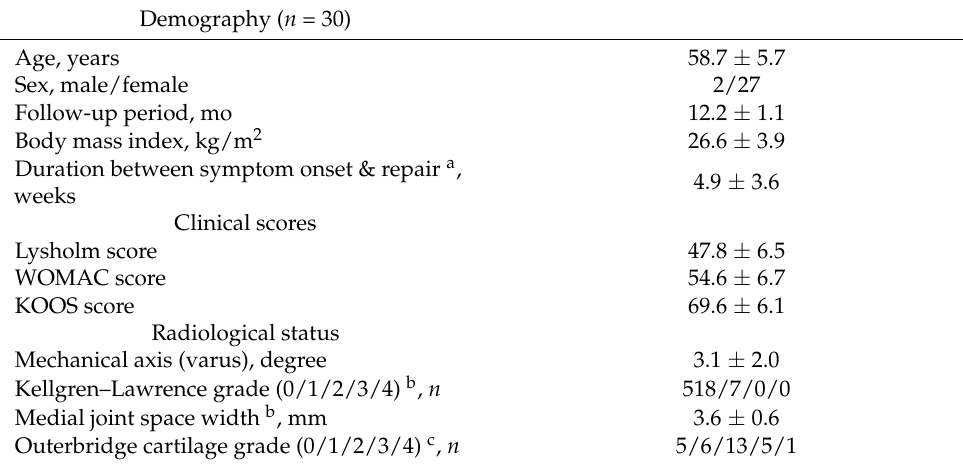
Table 1. Pre-operative Demographics and Characteristics of Patients